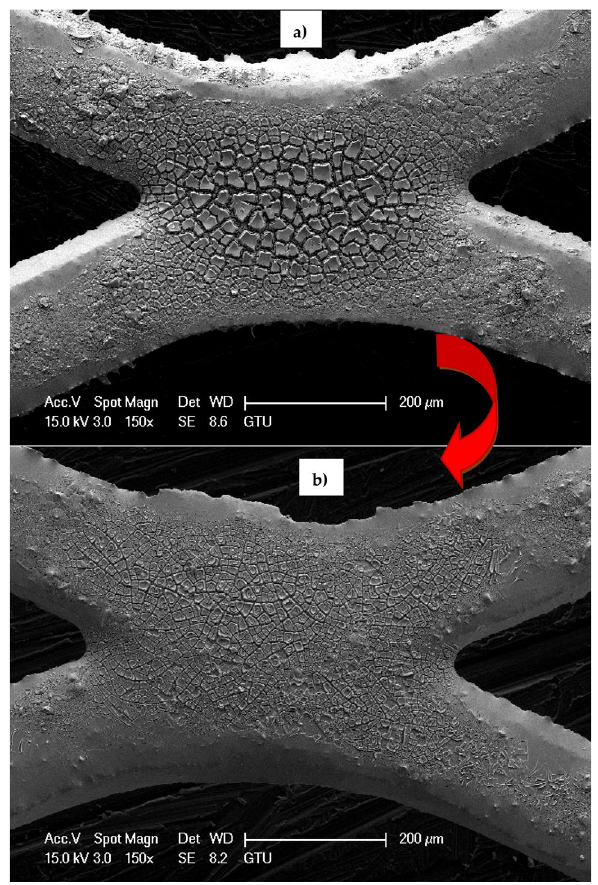
Figure 8. ( a ) Typical SEM images (× 150, bar = 200 μm) of Sn/Sb/Ni: 500/8/1 anodes. ( a ) Unused anode (clean product), ( b ) used anode (contaminated